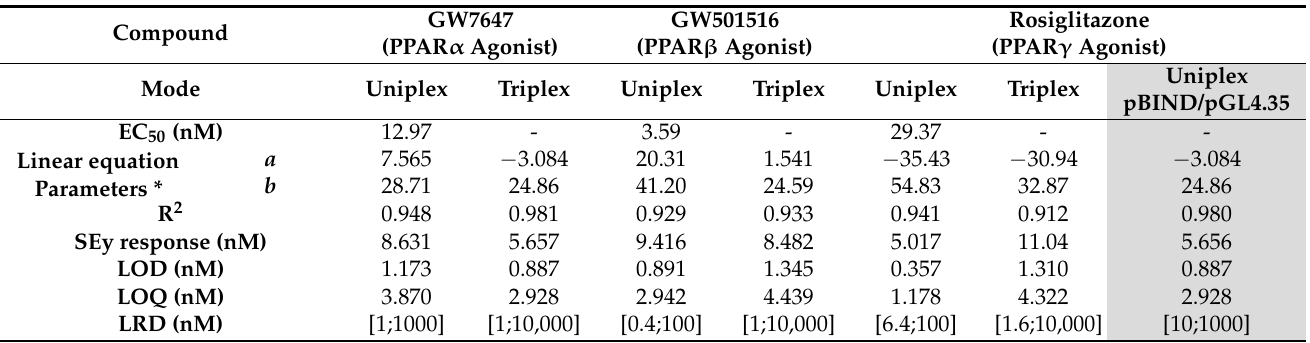
Table 1. Performance parameters determined for mpFN26A[Fluc]/mpGL4.35[Nluc] sensor system in uniplex and triplex modes, when reading different concentrations of PPAR α , - β or - γ agonists (GW7647, GW501516 or rosiglitazone, respectively). The performance parameters obtained for pBIND[Rluc]/pGL4.35[Fluc] system in uniplex mode, when challenged with rosiglitazone, are